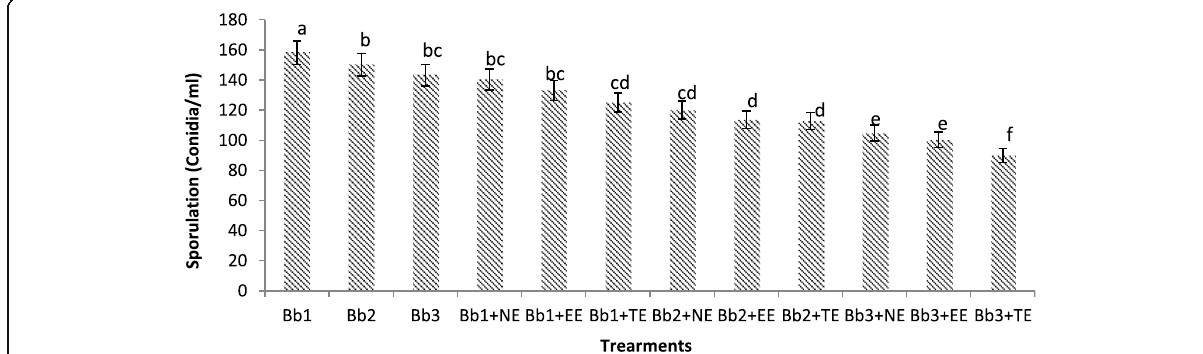
Fig. 2 Impact of the plant extracts and Beauveria bassiana (Bb) concentrations on sporulation in cadavers of 3rd instars larvae of Tribolium castaneum. Bars with the same letters are not significantly different at 5% significance level. Vertical bars reflect SE. Bb1, 0.3 × 10 8 conidia/ml; Bb2, 0.6 × 10 8 conidia/ml; Bb3, 0.9 × 10 8 conidia/ml ( F cal. = 4.43, df = 11, and P <